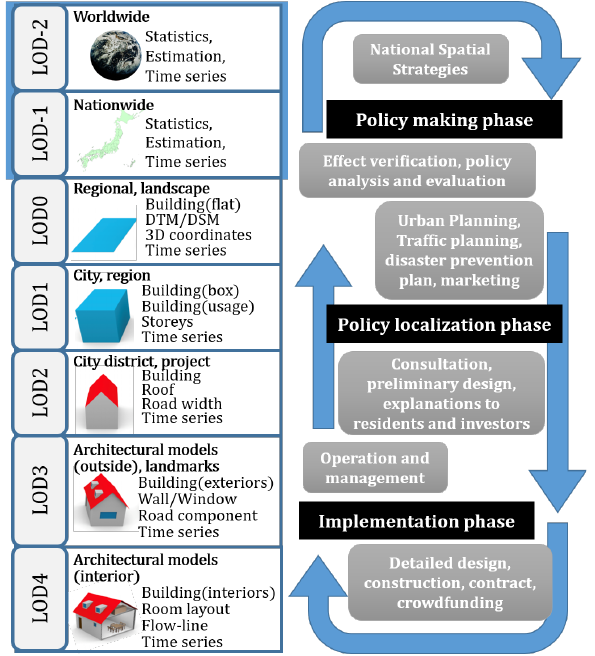
Figure 9. Concept of the Extended LOD (based on Biljecki et al., 2017 and Cabinet Office of Japan, 2019)